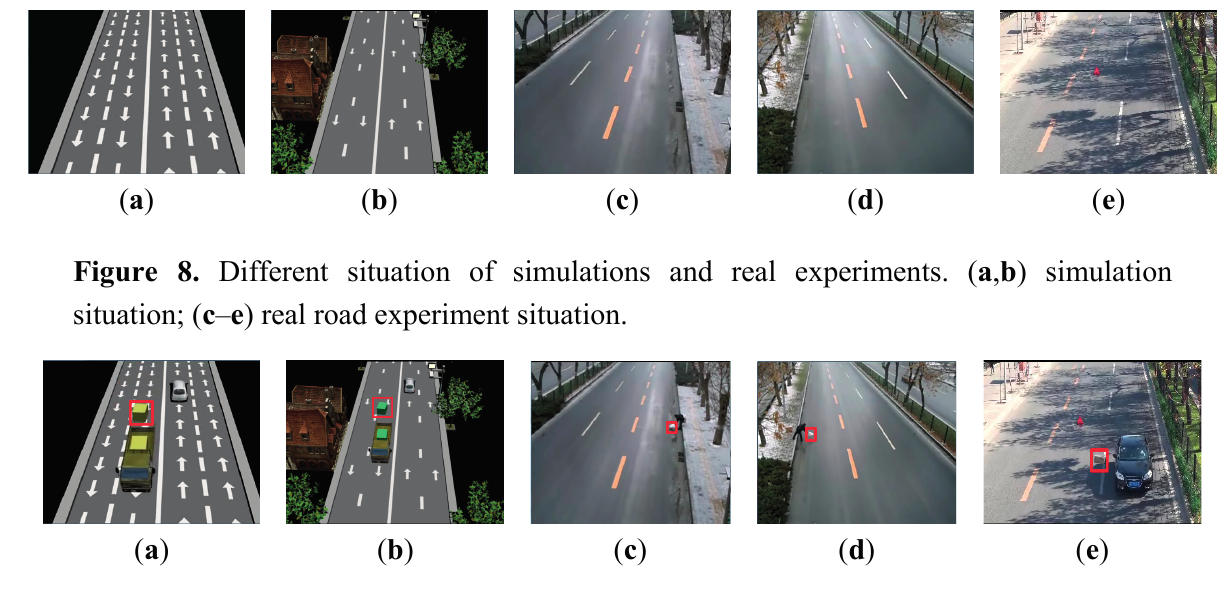
Figure 9. Processes of discarding abandoned objects. ( a , b ) are simulation examples; ( c – e ) are real road experiments.